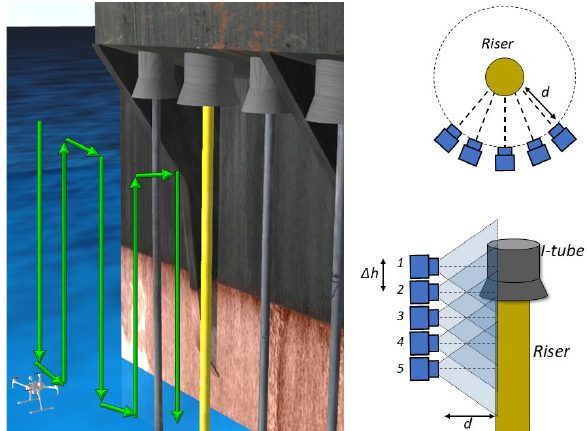
Figure 8. Serpentine trajectory schematic and acquisition top and side view. All five top positions are for a single